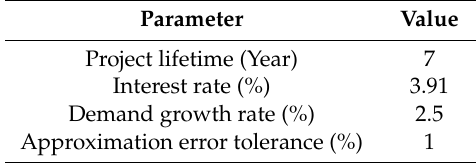
Table 3. Cost parameters used in multi-energy system expansion